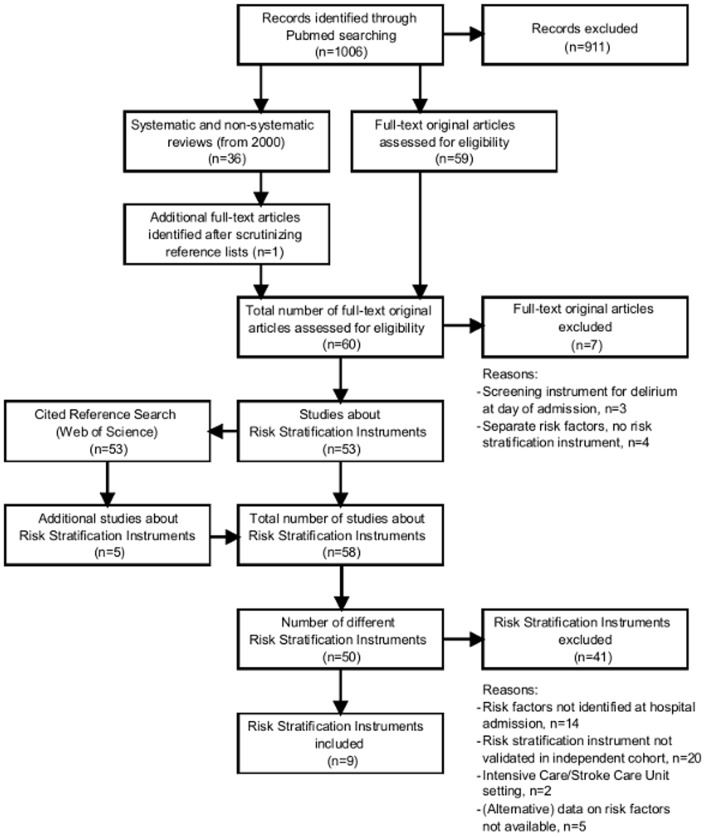
Flow diagram of the different phases of the review.For details of the excluded studies, see Text S1.